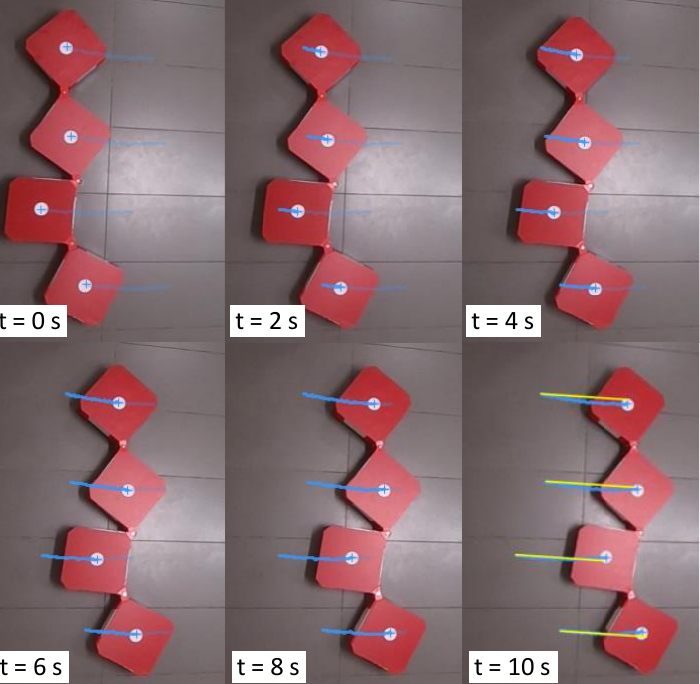
Figure 10. Snapshots taken, and the motion analysis during a locomotion with V 1 = 0.045 m/s, φ 1 = − π rad, and ω 1 = 0 rad/s. The traced paths are annotated in blue. The expected movement 4 paths are given in